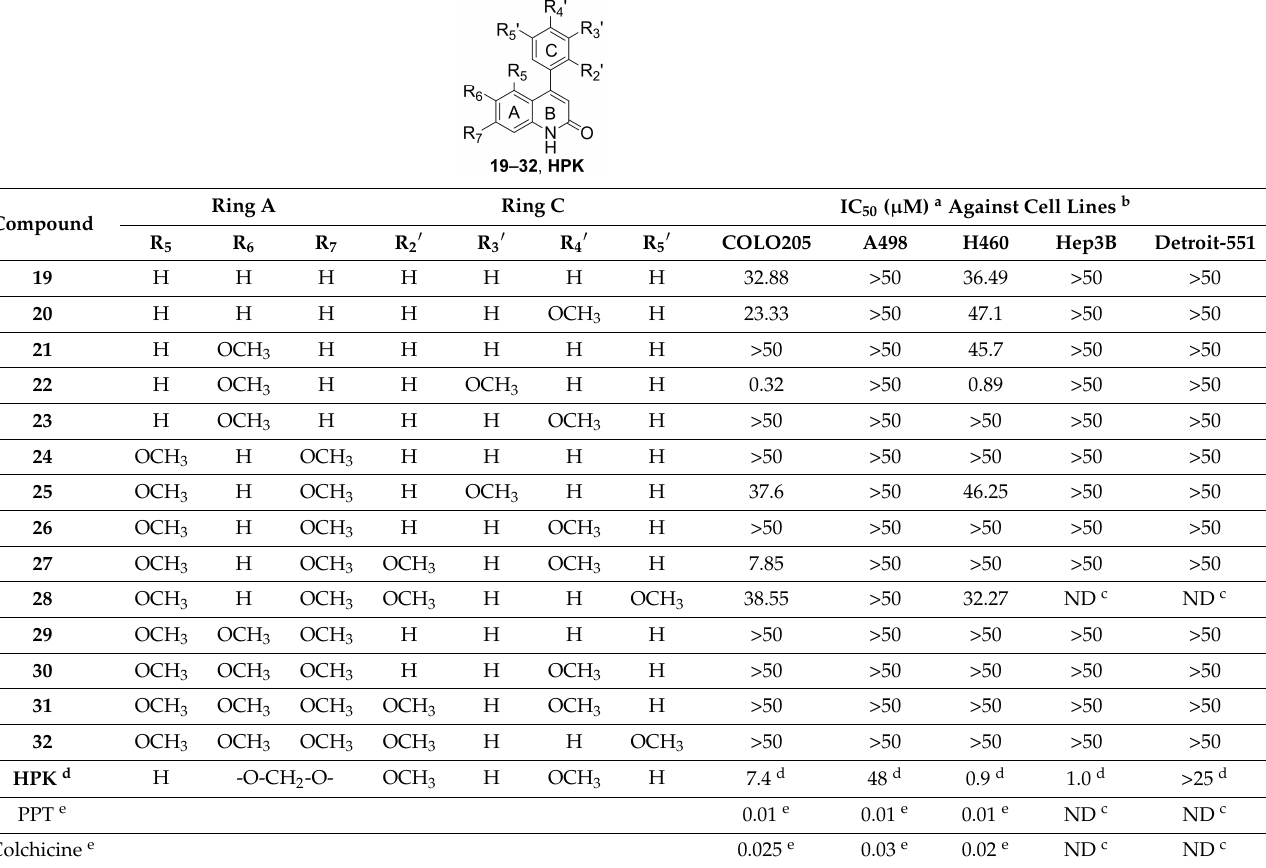
Table 2. Antiproliferative activities of 4-PQ derivatives.